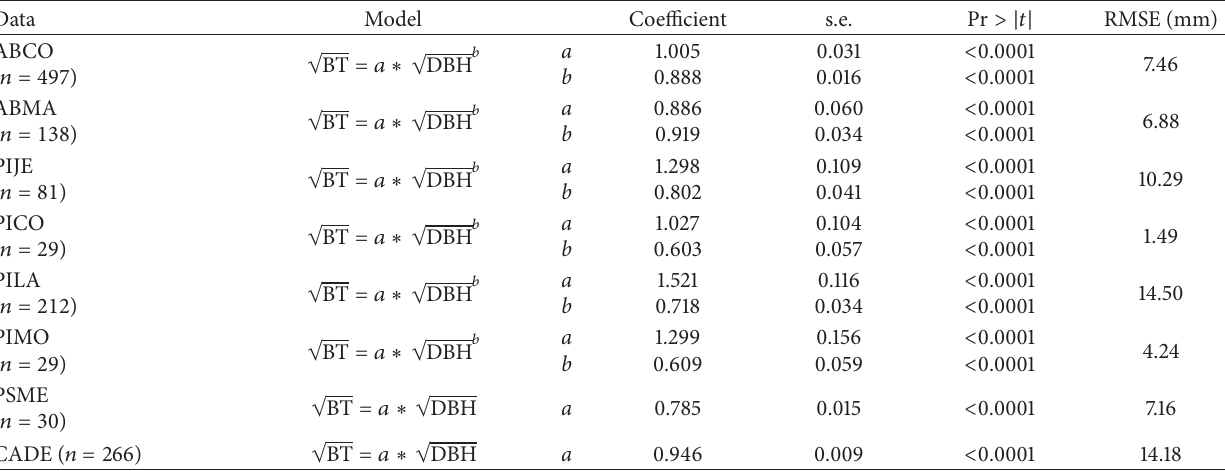
Table 3: Mixed-conifer forest type bark thickness (BT) models for red fir (ABMA), lodgepole pine (PICO), western white pine (PIMO), and Douglas-fir (PSME) at three sites: Klamath National Forest (KNF), Tahoe National Forest (TNF), and Sequoia National Forest (SNF), and models for white fir (ABCO), Jeffrey pine (PIJE), sugar pine (PILA), and incense-cedar (CADE) fitted to data from four sites including Stanislaus-Tuolumne Experimental Forest (STEF). Models predict square root of bark thickness in mm, as a function of DBH (cm).